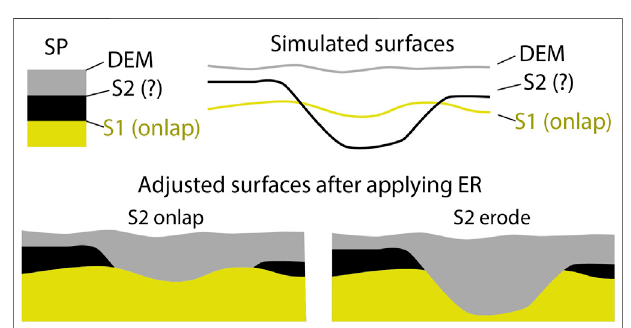
FIGURE3| Schematicexampleoftheerosionrules(ER)usedinArchPy. The surfaces are fi rst simulated from oldest to youngest and then adjusted following the